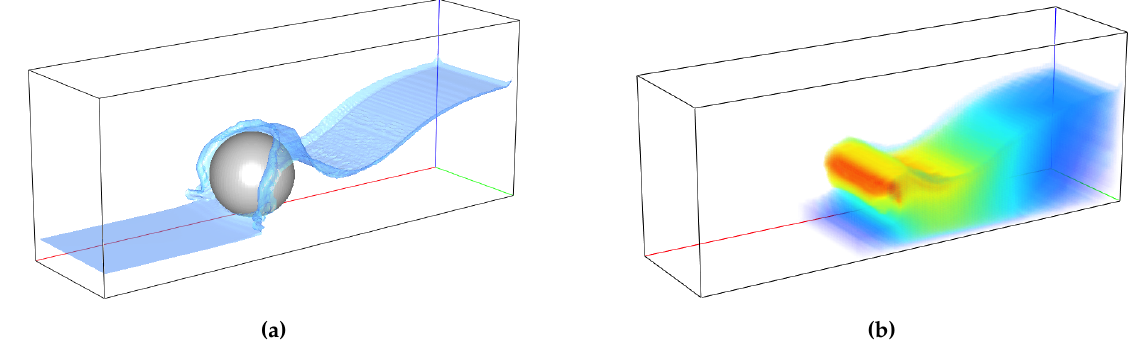
Figure 3. Two sophisticated three-dimensional visualizer features: ( a ) a free-surface dynamically computed with the marching cubes algorithm; ( b ) volume rendering applied to the dam break’s velocity magnitude